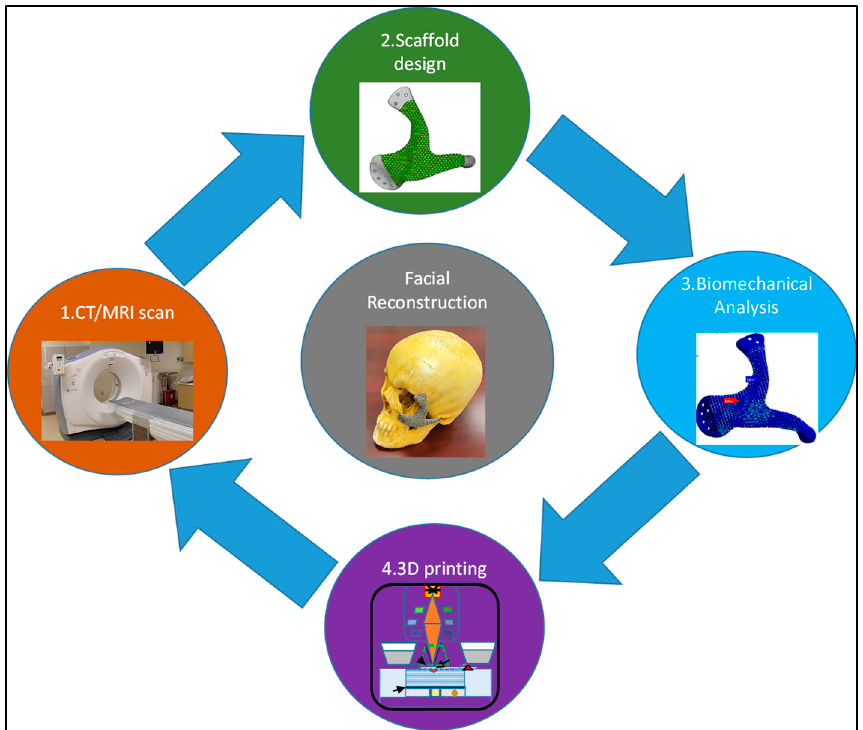
Figure 1. Schematic data flow in the reconstruction of craniofacial